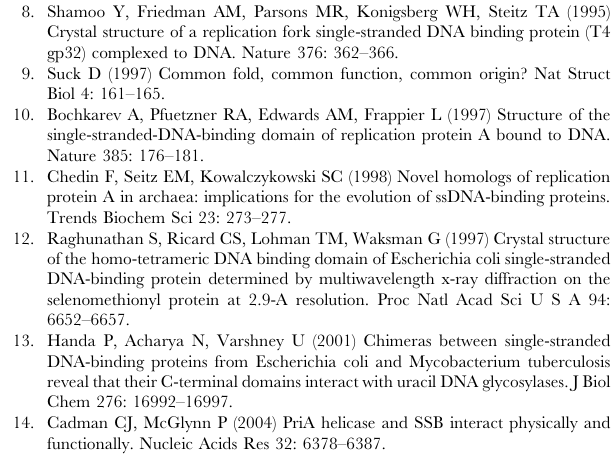
Figure S1 The gel filtration chromatography elution profiles of Eco SSB, Mtu SSB, m b 1– b 5 SSB, m b 1– b 6 SSB and D C SSB. Tetramer peak and Vo are indicated by dashed vertical lines. For further details see Figure 3. (TIF) Figure S2 Inverse fluorescence titrations. SSBs (0.1 m M) were titrated with increasing concentration of poly(dT) in buffer A (20 mM Tris.HCl, pH 8.0, 0.1 mM Na 2 EDTA) containing (i) 200 mM NaCl or (ii) 50 mM NaCl. The smooth curves represent the best fit data to 1:1 model of non-linear least squares isotherm (Materials and Methods). Table S1 Complementation analysis by plasmid bumping experiment. Table S2 List of DNA oligomers used for generating chimeric SSBs. Table S3 Nucleotide and amino acid sequences of SSB